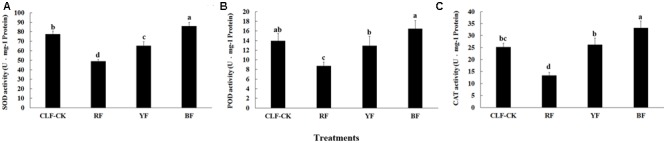
Effects of different color films on (A) SOD, (B) POD, and (C) CAT activity of A. roxburghii. Values are the means ± SE of triplicate assays. Data in columns with the different letters are significantly different P < 0.05.